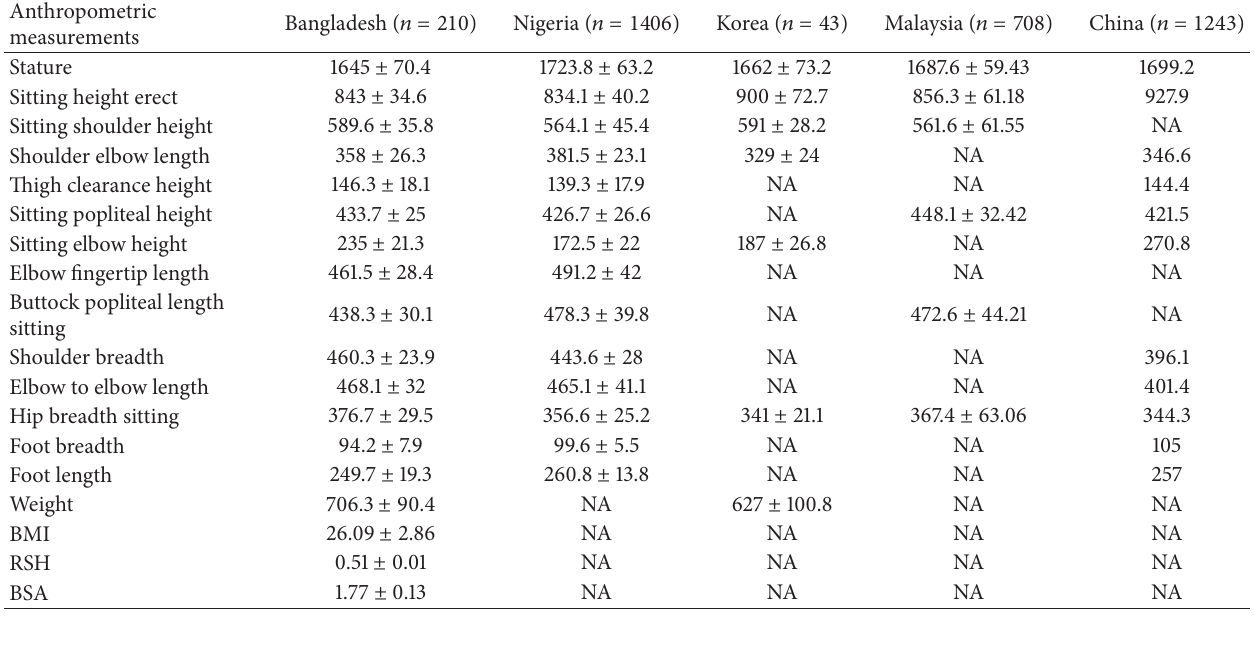
Table 3: Comparative study of anthropometry of driver with other nationalities.